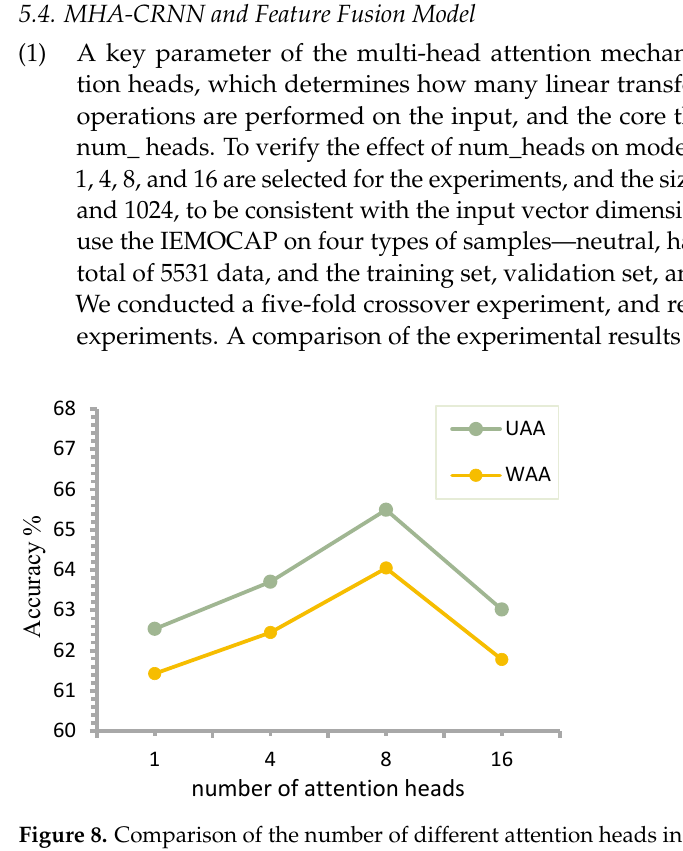
Figure 8. Comparison of the number of different attention heads in the MHA-CRNN